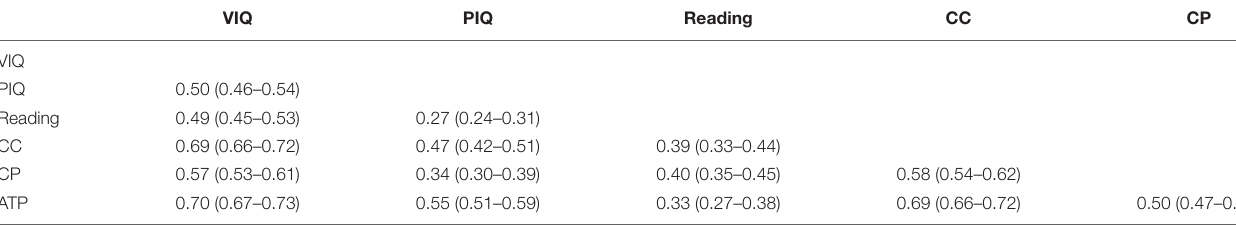
TABLE 2 | Phenotypic correlations with 95% confidence intervals (ML) among study variables.